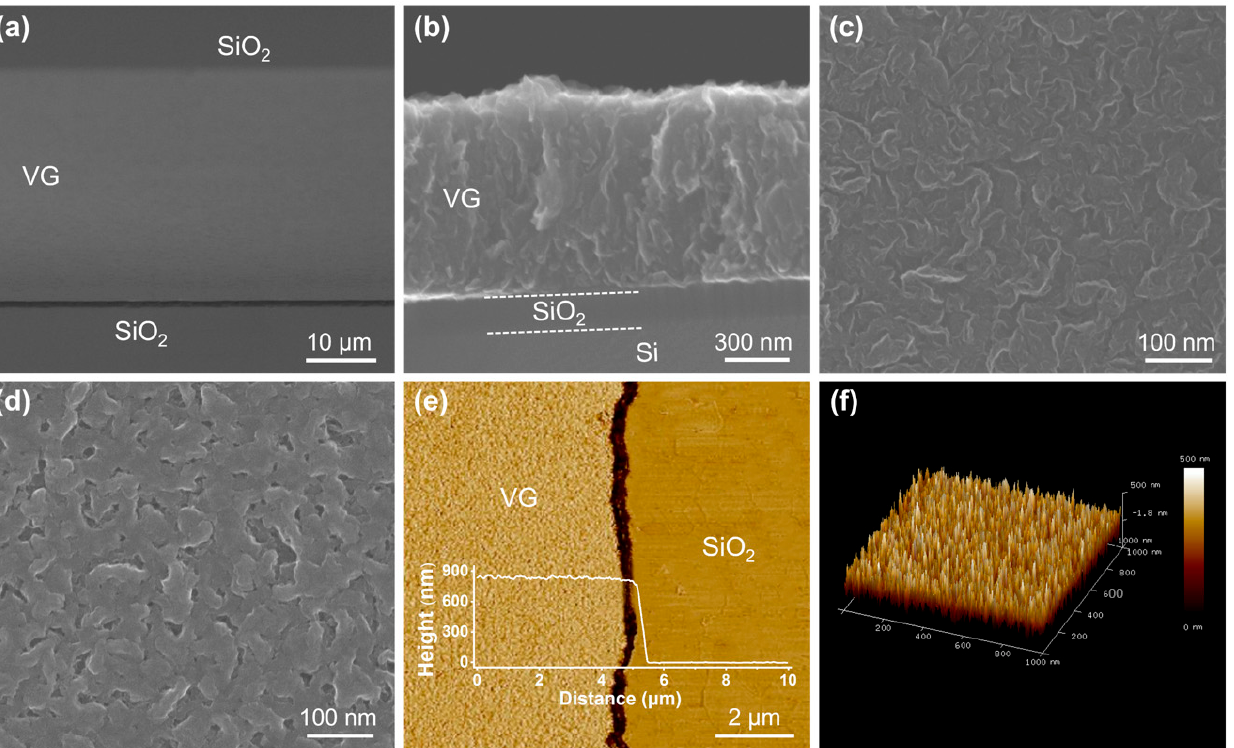
Figure 4. Morphology of the patterned VG: ( a ) oblique view SEM image, ( b ) cross-sectional view SEM image, and ( c ) top view SEM image of the patterned VG grown directly on a SiO 2 /Si sub- strate. ( d ) Top view SEM image of the patterned VG prepared using conventional photolithogra- phy-O 2 plasma etching process. ( e ) Two-dimensional image of the grown VG pattern boundary in a 10 μ m × 10 μ m area. ( f ) Three-dimensional AFM image of the grown VG distribution in a 1 μ m × 1 μ m area.